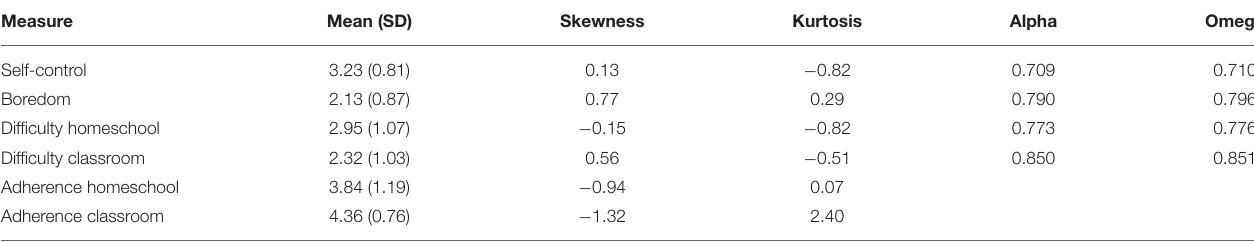
TABLE 1 | Descriptive summary of